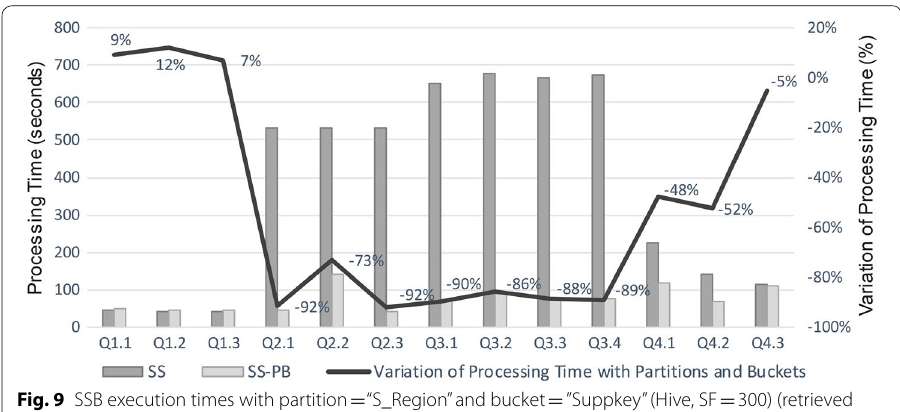
Fig. 9 SSB execution times with partition from